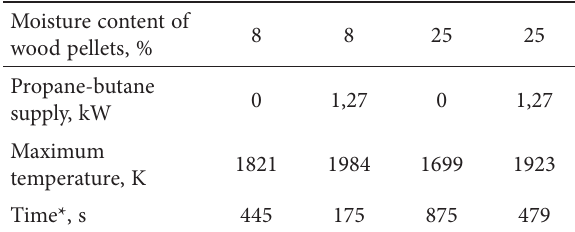
Table 3. The influence of moisture content in wood pellets and propane-butane supply on fuel